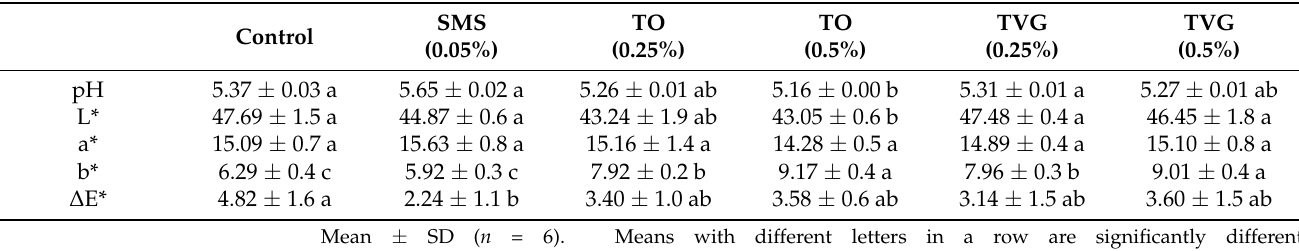
Table 3. pH and colour properties of vacuum-packed beef mince treated with TO and TVG at the end of refrigerated storage.